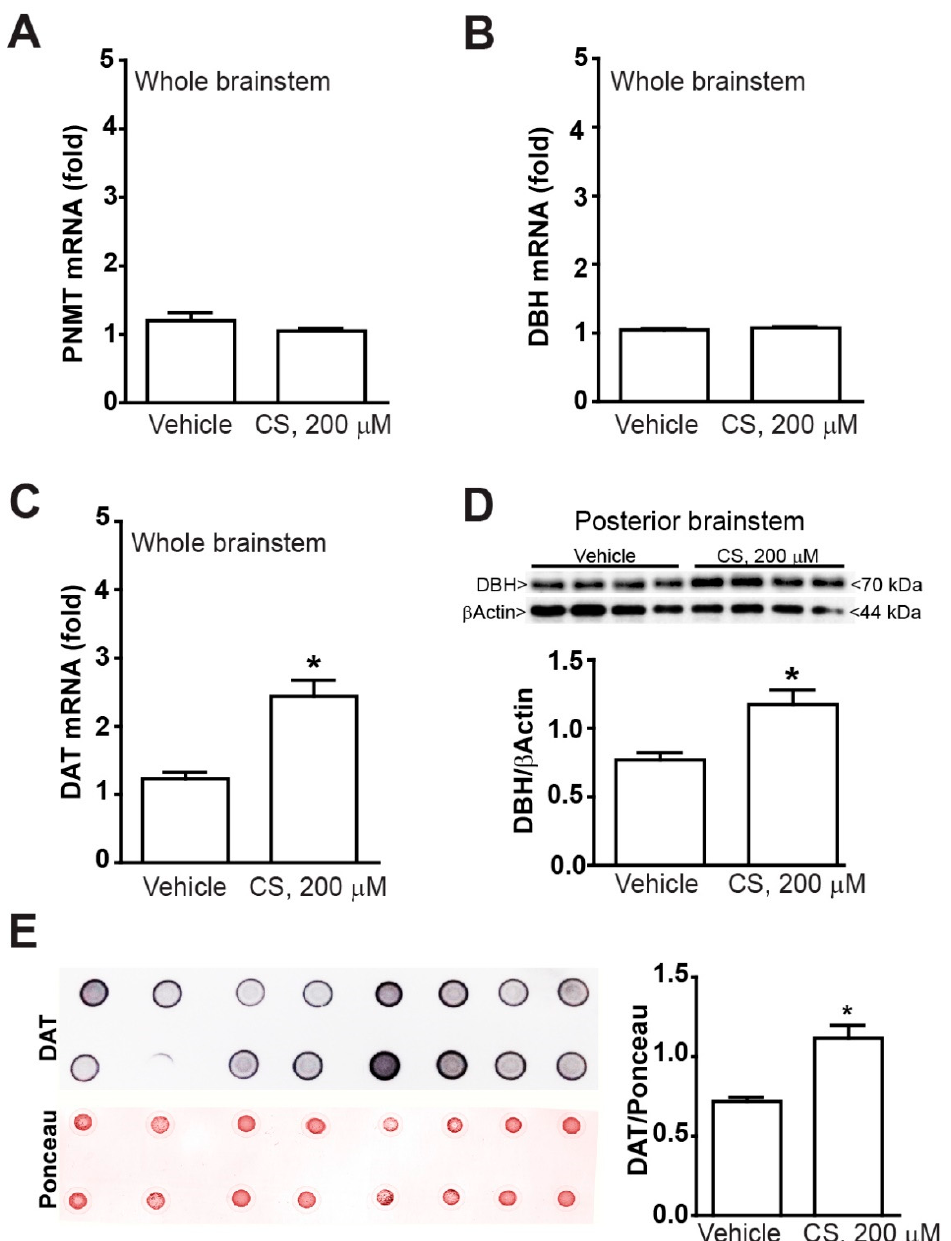
Figure 5. The highest dose of corticosterone increases DBH expression without modifying PNMT expression in the mouse brainstem. Real time PCR of ( A ) the adrenergic marker PNMT, ( B ) the noradrenergic marker DBH and ( C ) the dopaminergic marker (DAT) in the whole mouse brainstem at 24 h incubation